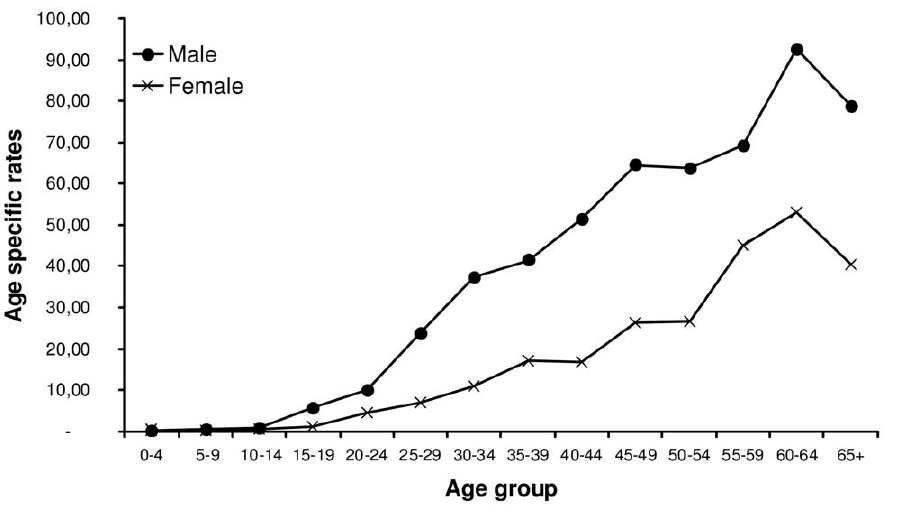
Figure 1. Liver cancer incidence rates per 100000 Gambians by 5-years age groups. Data from the Gambia National Cancer Registry, 1998– 2006.